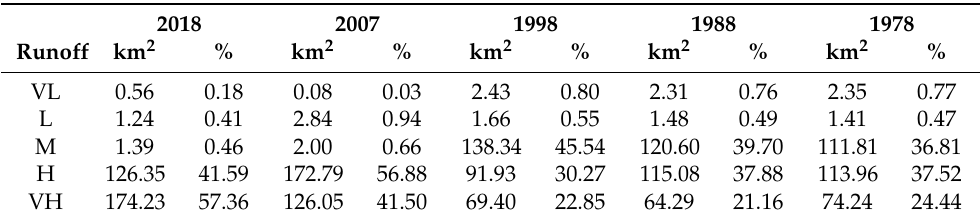
Table 10. Decadal runoff classes for Dhaka city with inundation area (km 2 ) and percentage (%) with respect to the city area.